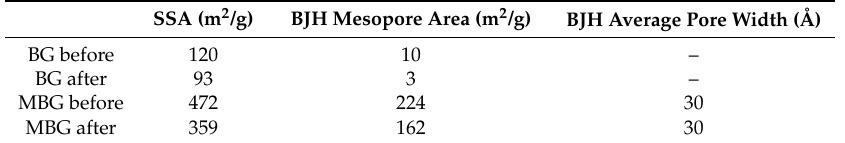
Table 3. N 2 adsorption analysis performed on MBG sample before and after the soaking in